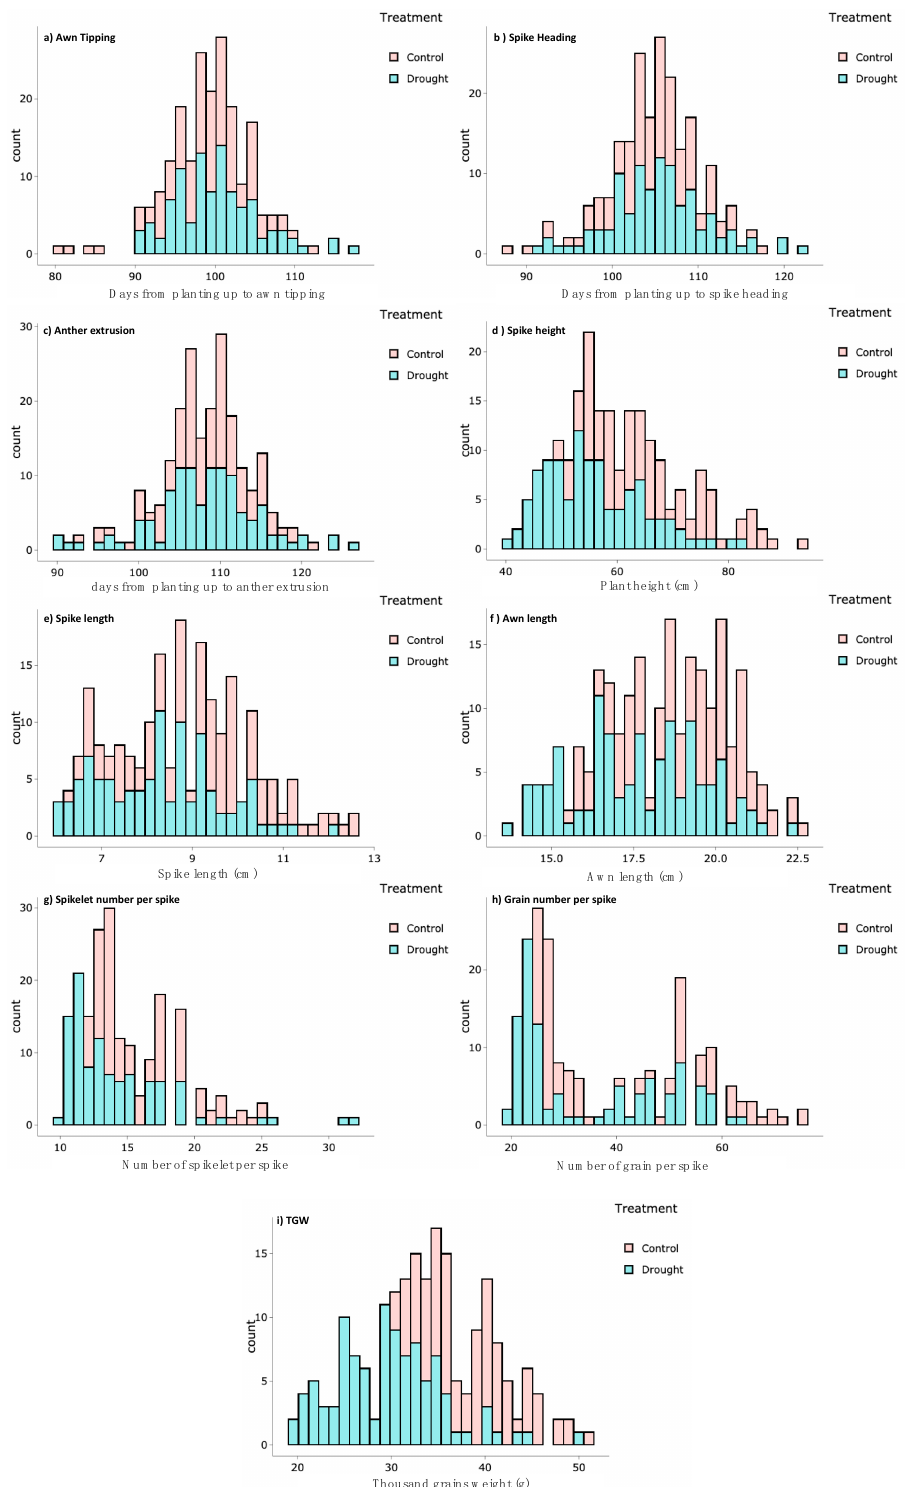
Figure 1. Histogram of phenotypic values distribution analysis of the studied traits; ( a ) Awn Tipping, ( b ) Spike Heading, ( c ) Anther Extrusion, ( d ) Plant Height, ( e ) Spike length, ( f ) Awn Length, ( g ) Spikelet per Spike, ( h ) Grain per Spike and ( i ) Thousand Grain Weight (TGW) in 121 spring barley accessions under control and drought stress.